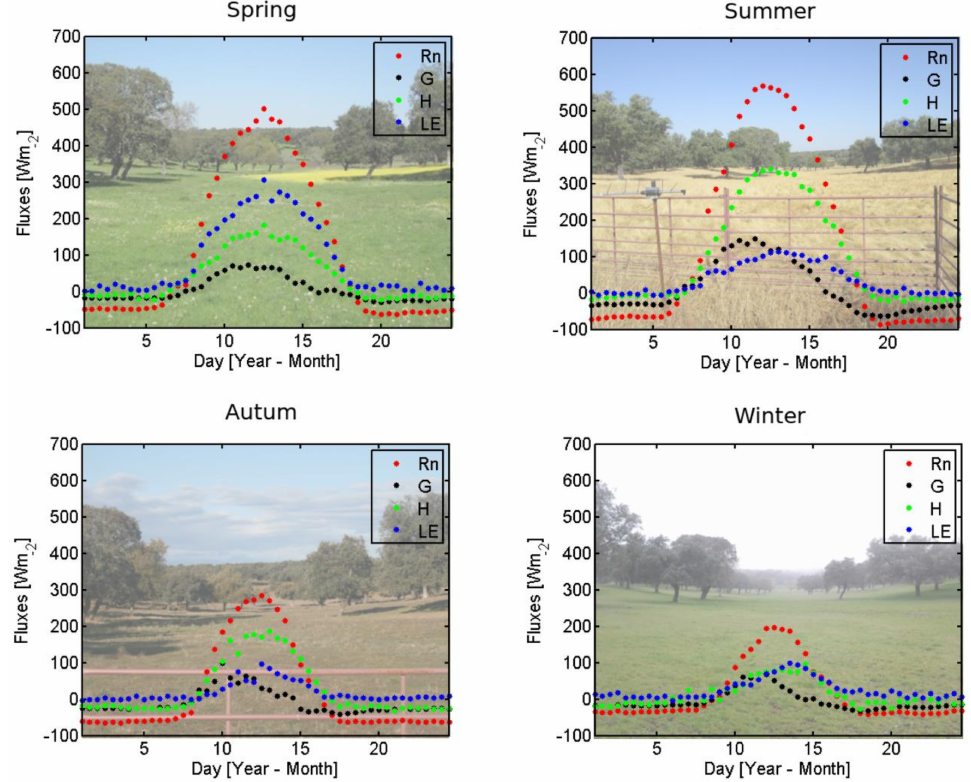
Figure 3. Typical diurnal fluxes from one of the experimental sites (Santa Clotilde) for the different